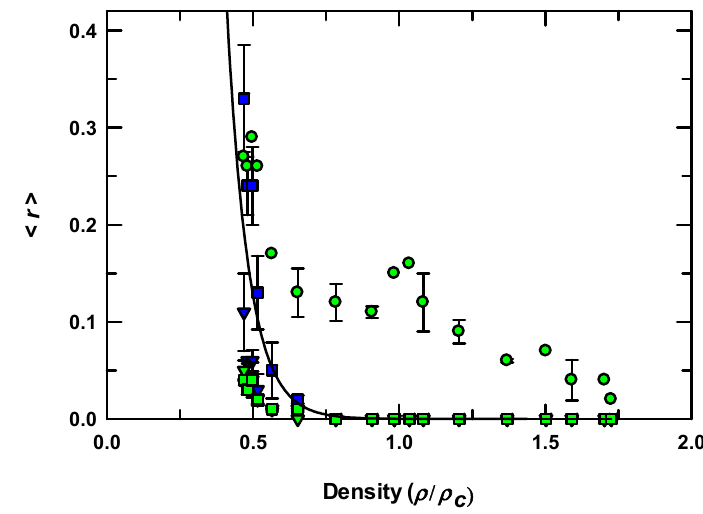
Figure 5. Density dependence of the anisotropy of C153 in [P 6,6,6,14 ] + [Tf 2 N] − / scCO 2 . Blue symbols show data acquired with emission fixed at 22,222 cm − 1 , whereas green symbols are the anisotropy with emission at 19,608 cm − 1 . Excitation was varied for each emission using 27,397 cm − 1 (inverted triangles), 24,691 cm − 1 (squares), and 22,222 cm − 1 (circles). Uncertainties are contained within the size of the symbol except for where there are visible error